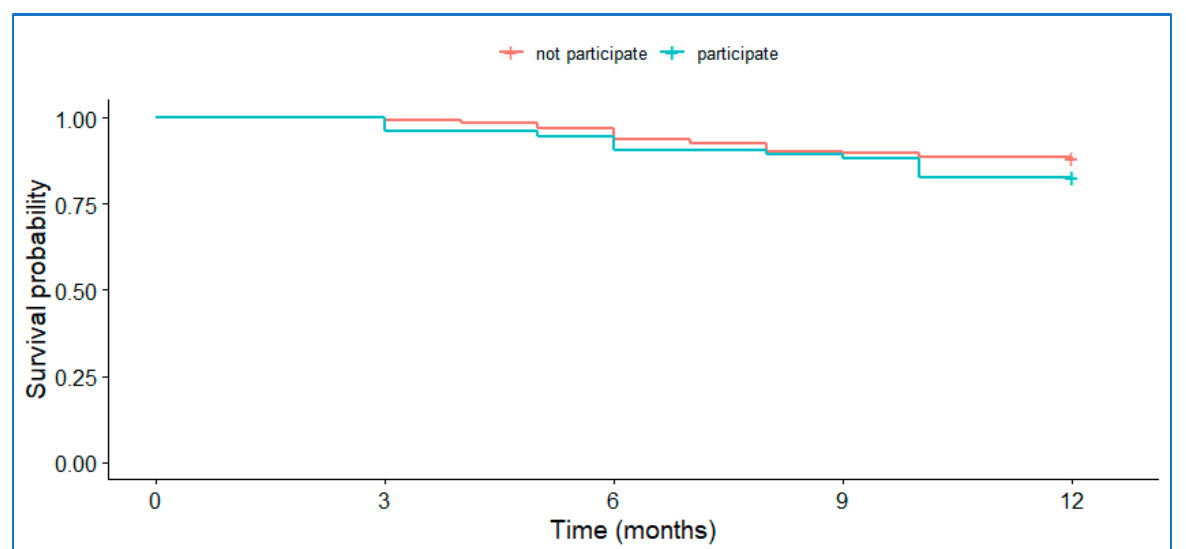
Figure 3. Adaptation in research/technology (Ad16).